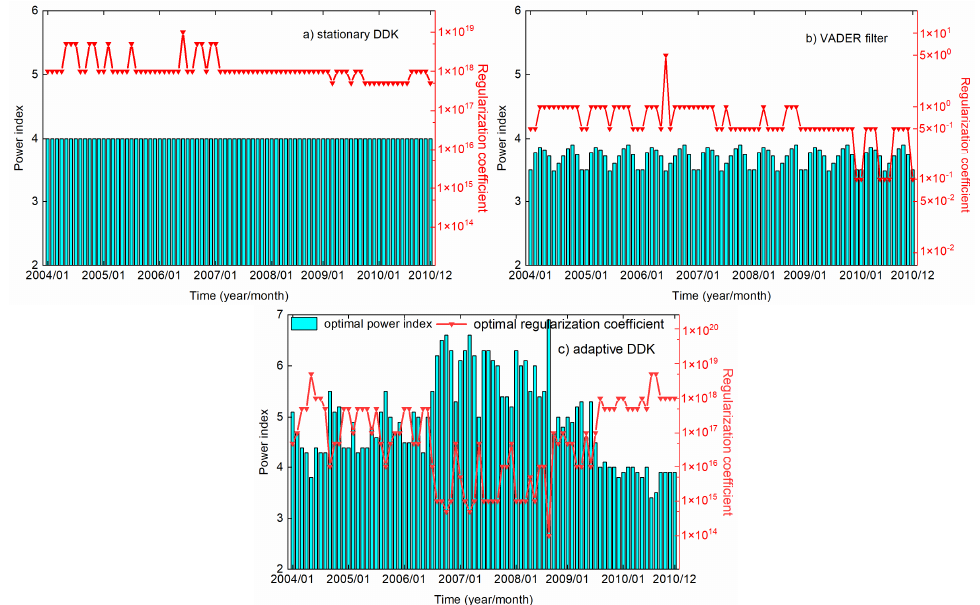
Figure 2. The optimized hyperparameters for each month from January 2004 to December 2010 through GCV criterion: ( a ) stationary DDK, ( b ) VADER filter, ( c ) adaptive DDK. Note that the power indices for VADER filter are taken from Figure 2 in [12].